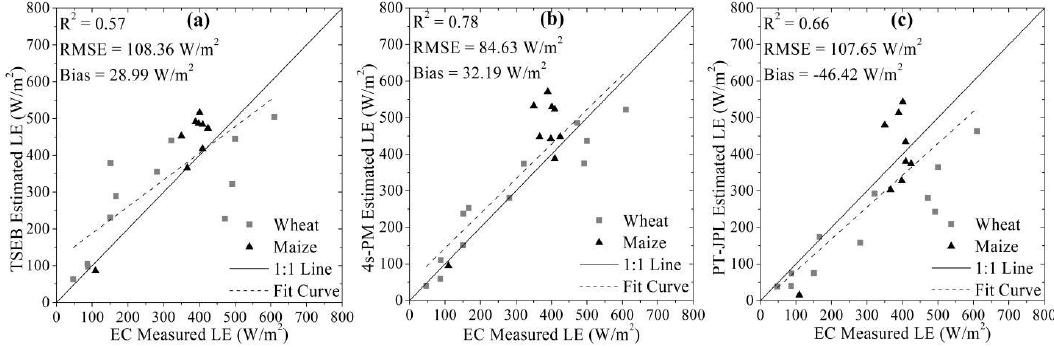
Figure 5. Validation of the instantaneous LE for different modes: ( a ) TSEB, ( b ) 4s-PM, and ( c ) PT-JPL.